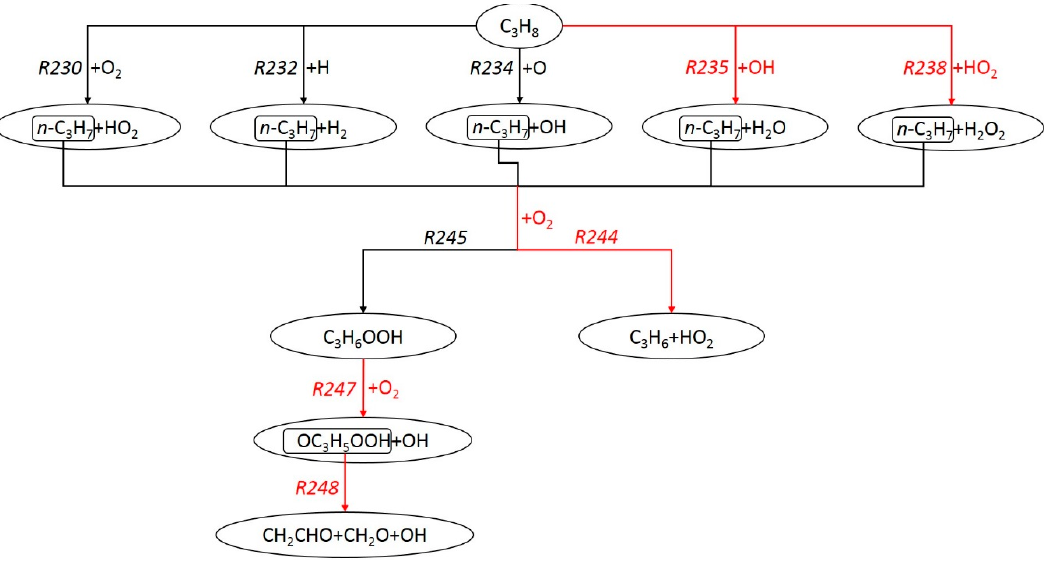
Figure 11. Extract from the propane oxidation scheme derived from MechA. Reactions with modified Arrhenius parameters to improve the calculation of the propane influence on the IDT are labeled in red. Table 3. Overview of the reactions used to adjust the calculation of the propane influence on the IDT. Reaction Number Reaction Equation